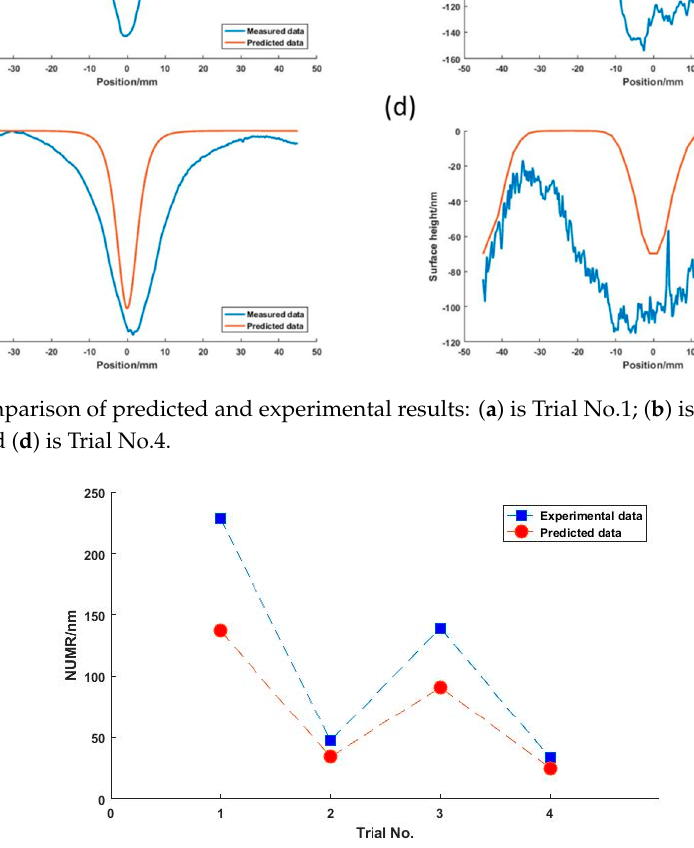
Figure 9. Comparison of the predicted and the experimental value of NUMR.